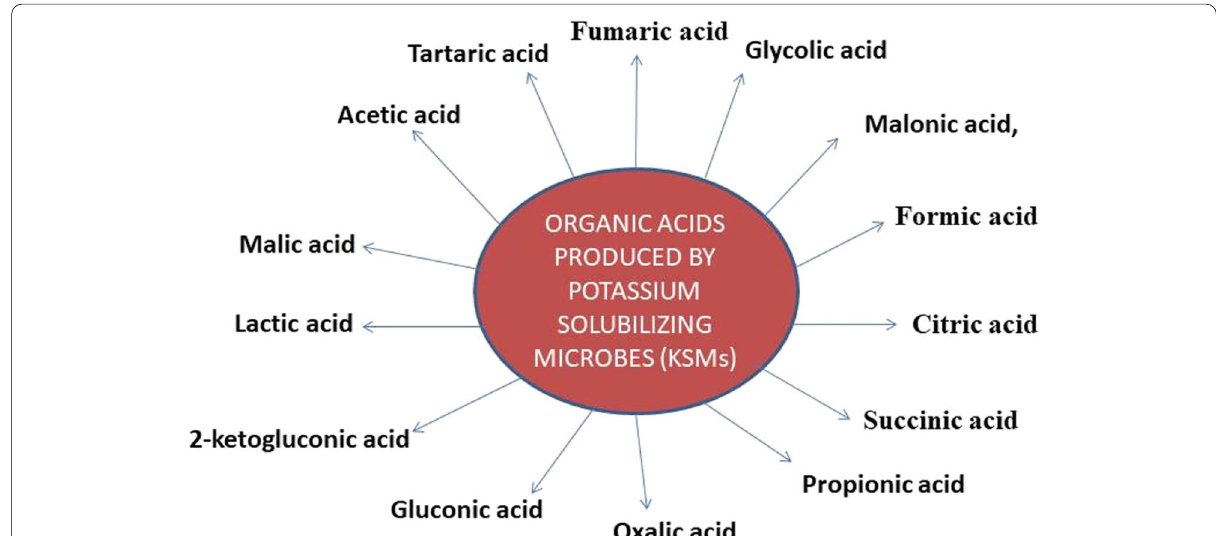
Fig. 2 Diversity of organic acids produced by potassium solubilizing